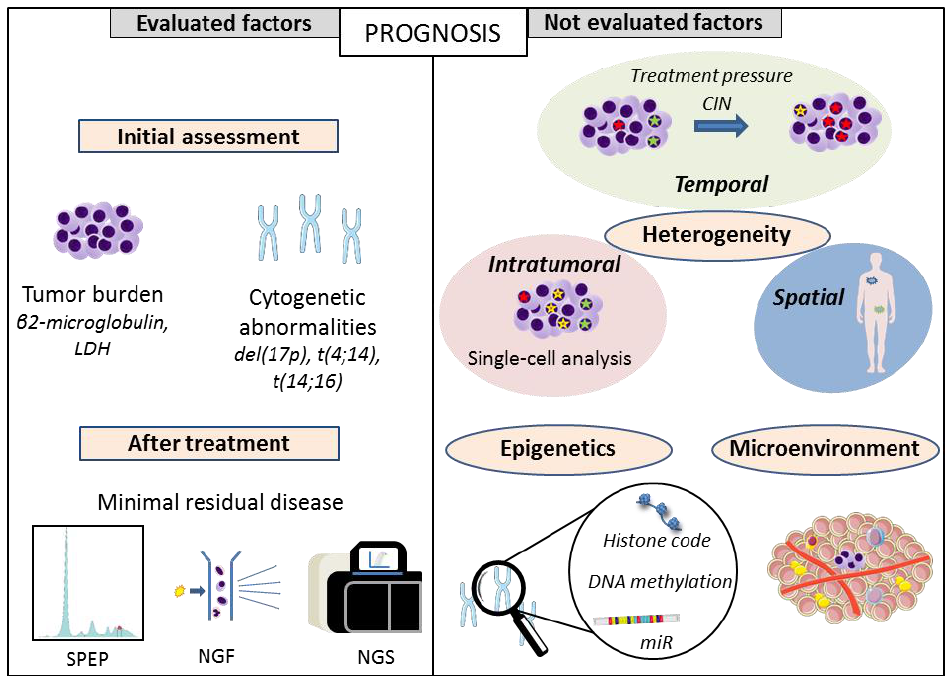
Figure 1. Prognostic factors: routinely evaluated versus not evaluated factors. SPEP: serum protein electrophoresis, NGF: next-generation flow, NGS: next-generation sequencing.